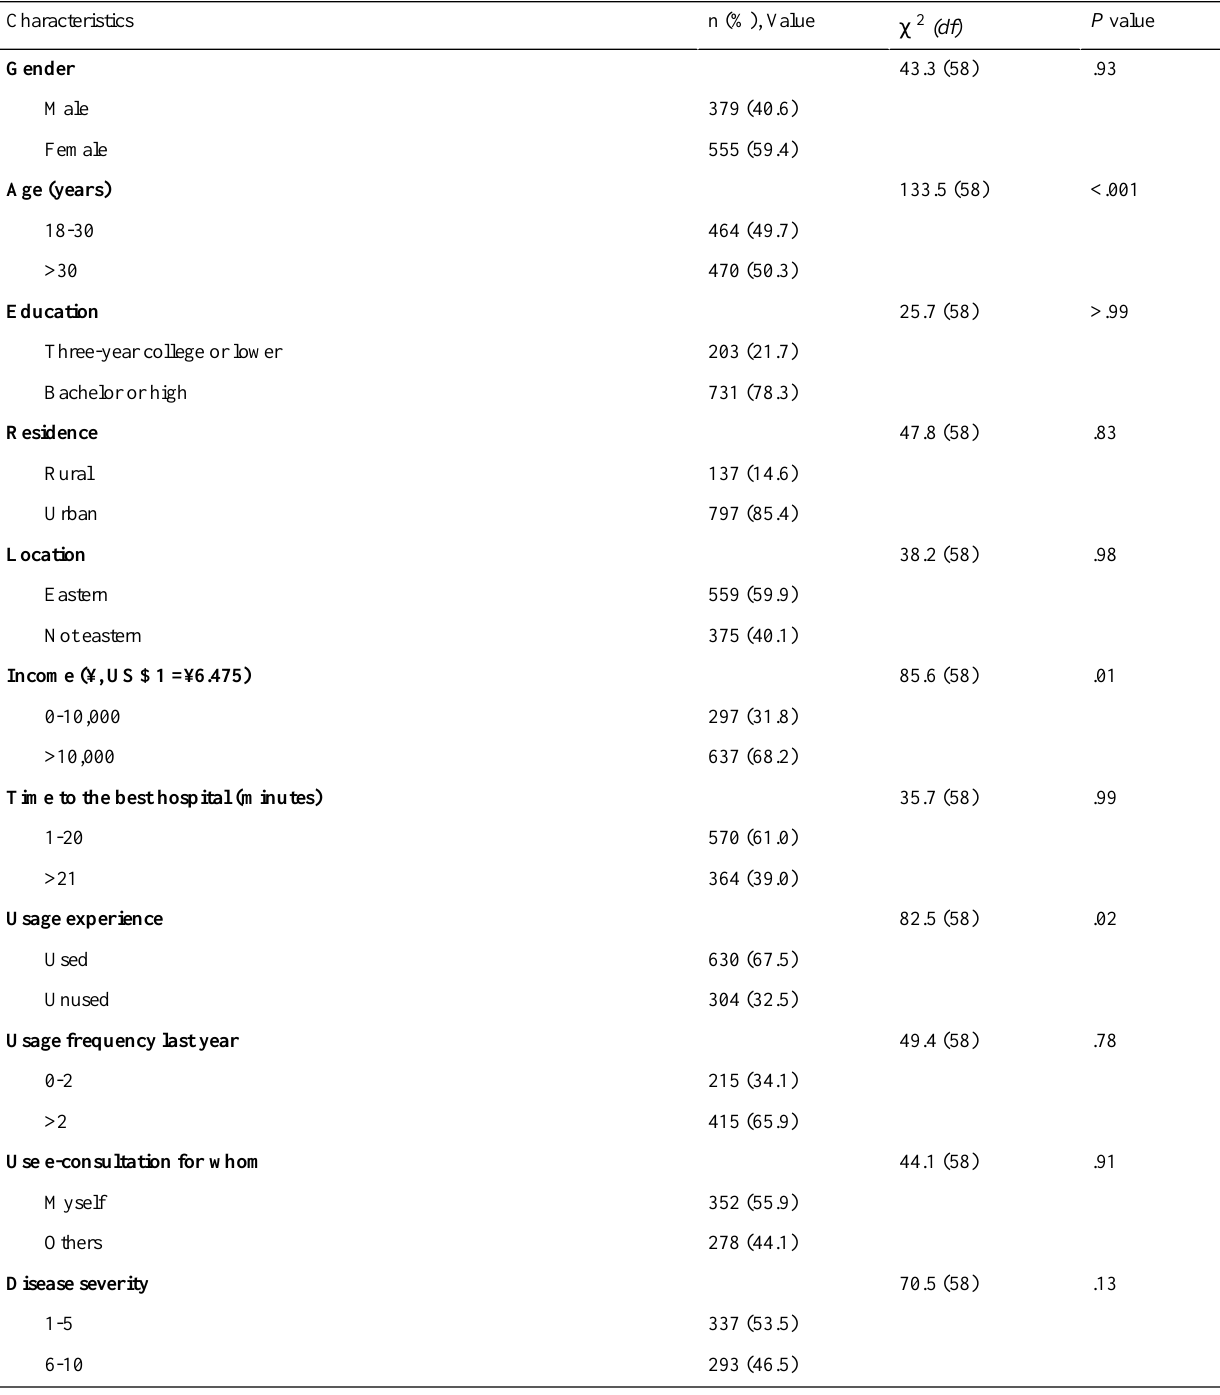
P value χ 2 (df) n (%),